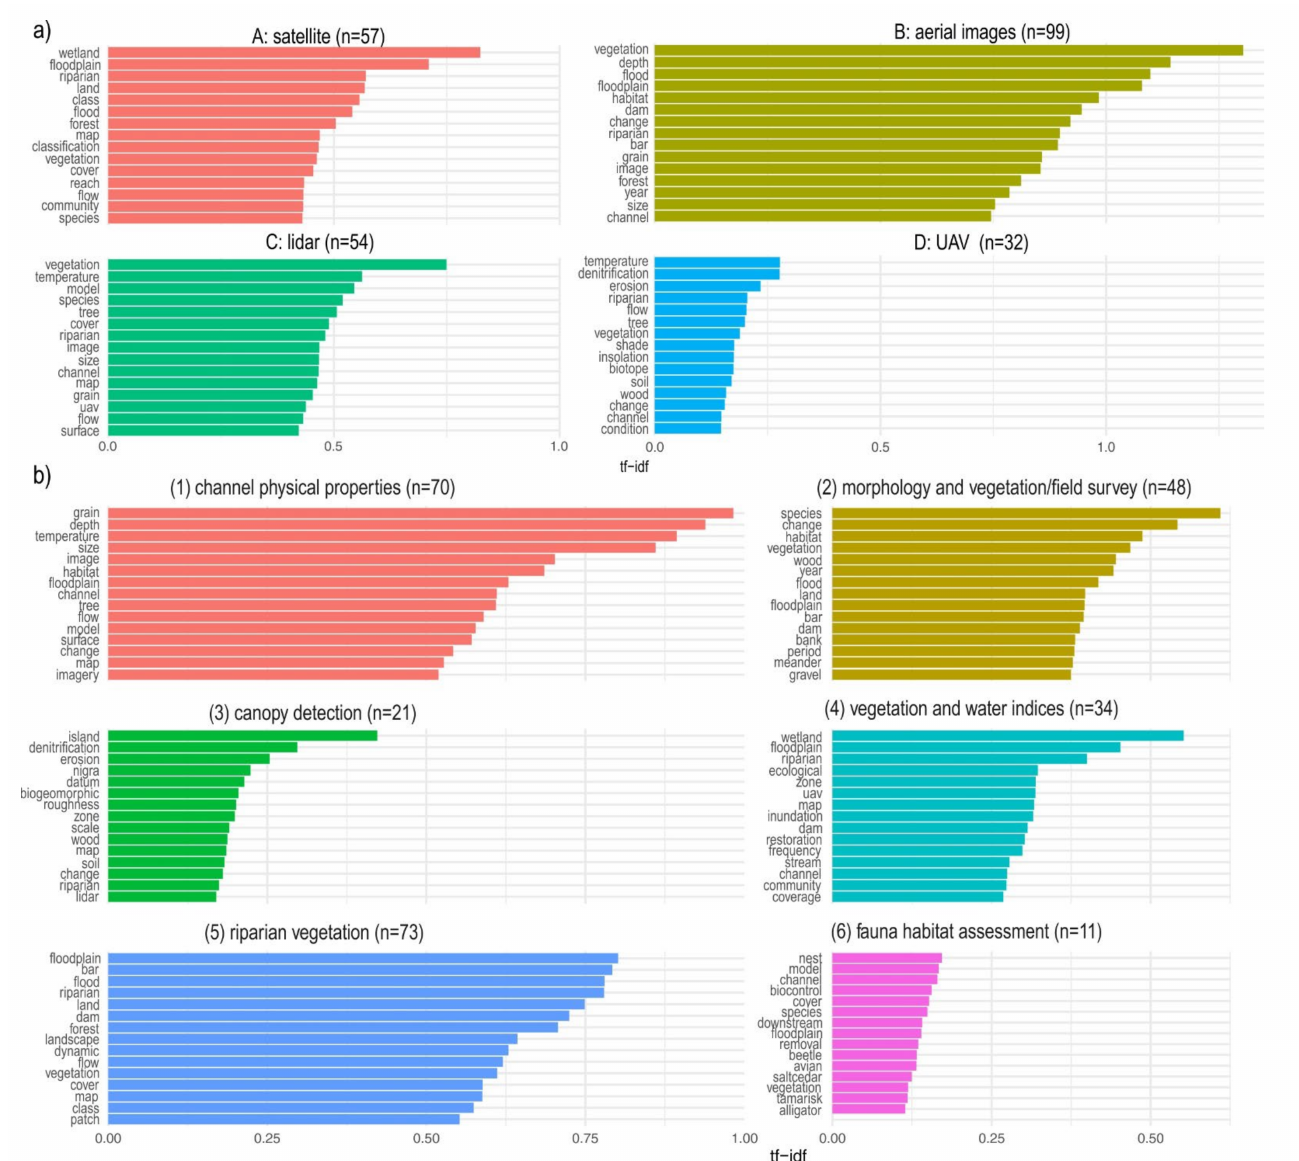
Figure 6. Word importance of the abstract clusters based on the tf-idf. Clusters were divided ( a ) into four main groups based on the types of remote sensing sensor and ( b ) the six main categories from the content